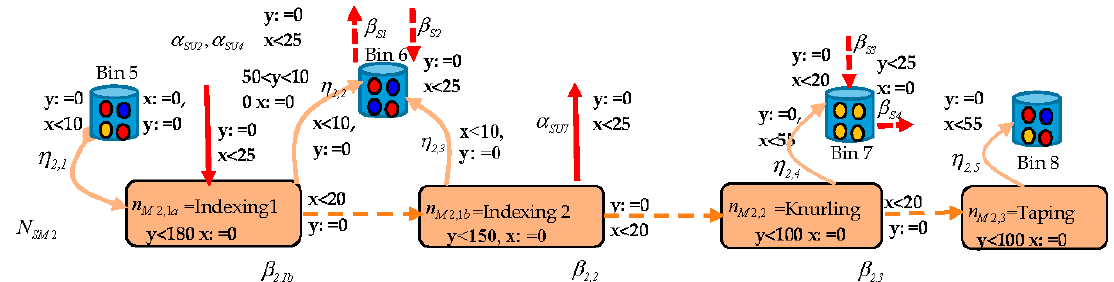
Figure 10. Supervisor Interface.